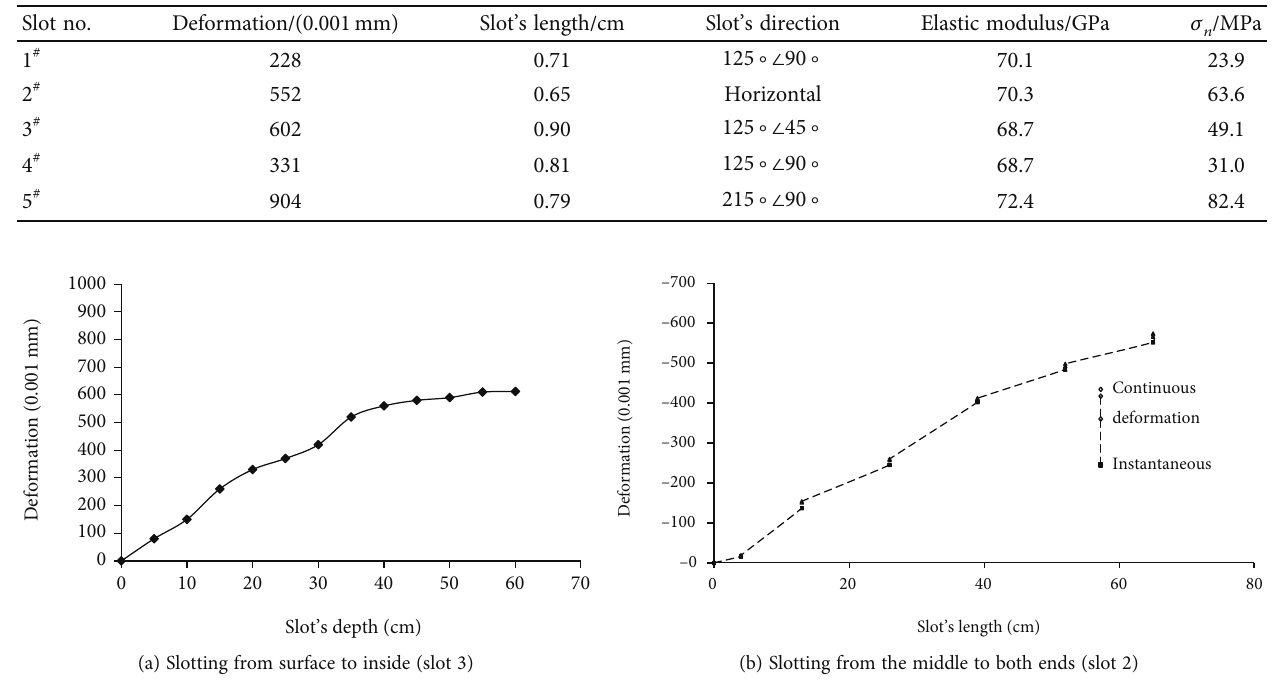
Table 1: Test results of rock mass parameters.